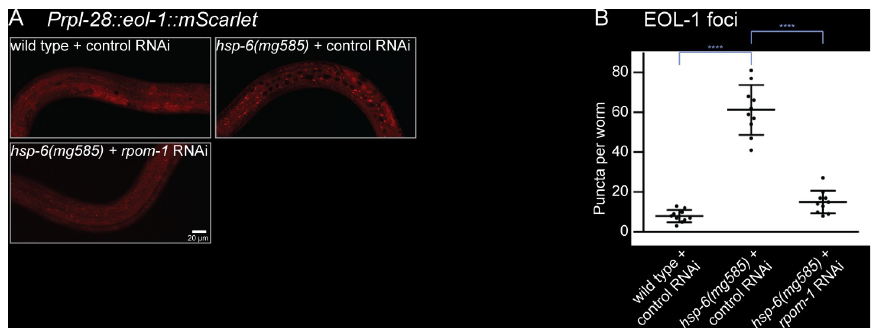
Fig 6. Formation of EOL-1 foci requires the biogenesis of mitochondrial RNA. (A and B) Formation of EOL-1 cytoplasmic foci requires the transcription of mitochondrial RNA from mitochondrial genome by RPOM-1 RNA polymerase. The EOL-1::mScarlet foci formed in the hsp-6(mg585) mutant were inhibited by RNAi of mitochondrial RNA polymerase rpom-1 / POLRMT. Animals were imaged in (A), and the number of foci was quantified in (B). ���� denotes p < 0.0001. The underlying numerical data can be found in S1